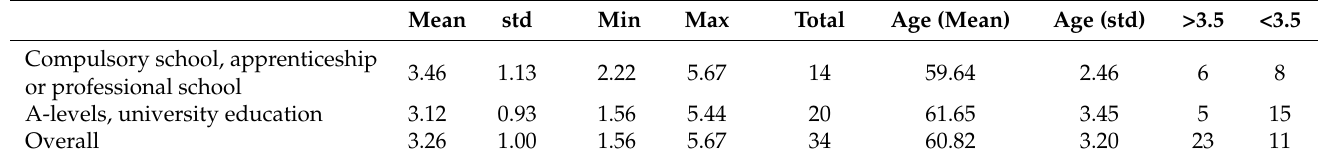
Table 4. Summary of the ATI scale based on the educational level ( n =